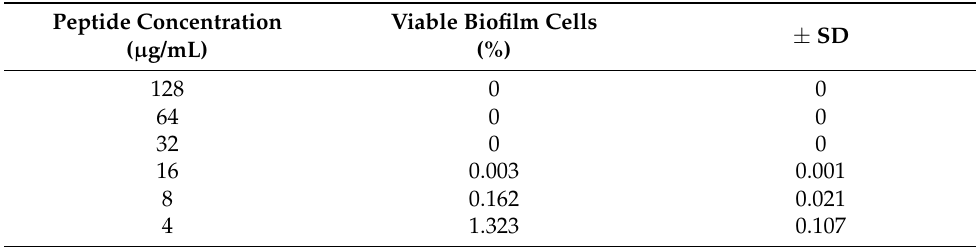
Table 3. Viable biofilm cells of multidrug-resistant enterotoxigenic Escherichia coli (MDR ETEC) after treated with Q4-15a-1 for 24 h.